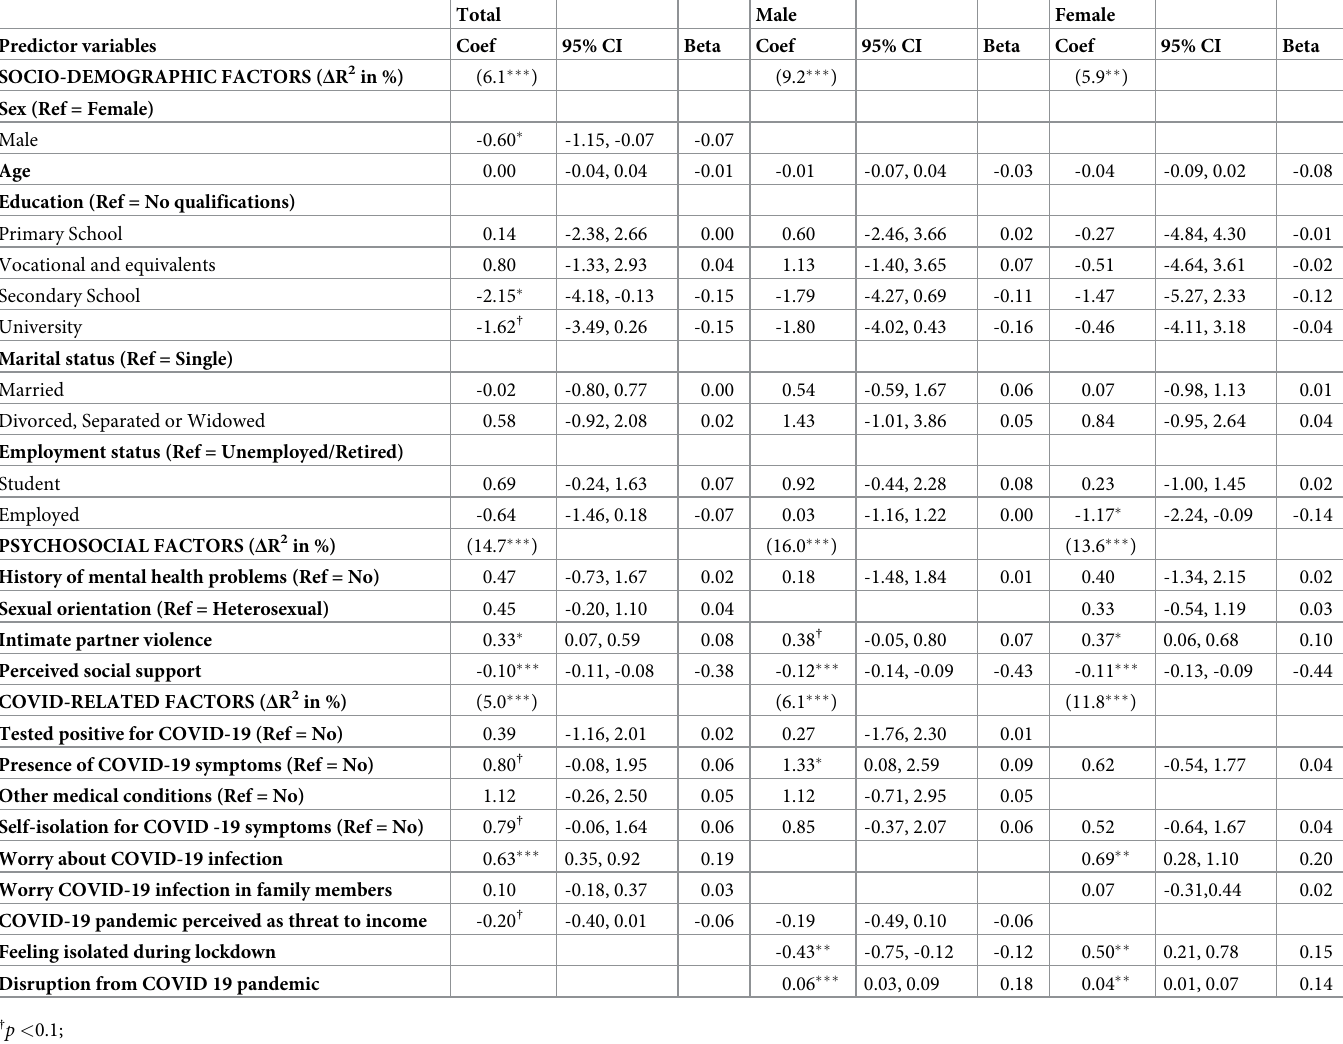
Table 4. Multivariate associations between anxiety symptoms and predictors with sex